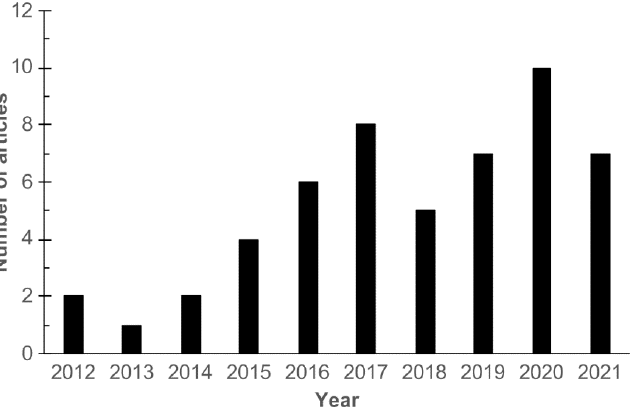
Figure 2. The number of research articles on autophagy modulation by GNM. The relevant articles were identified by searching the PubMed database using the search terms “graphene” and “autoph- agy”.